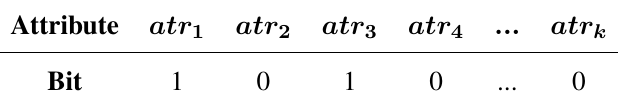
Table 2. An example of a bitmap for attributes interested in a certain query q , where atr specifies the i -th attribute. The value 1 means that a certain attribute (e.g., atr in this query q , while 0 means it is